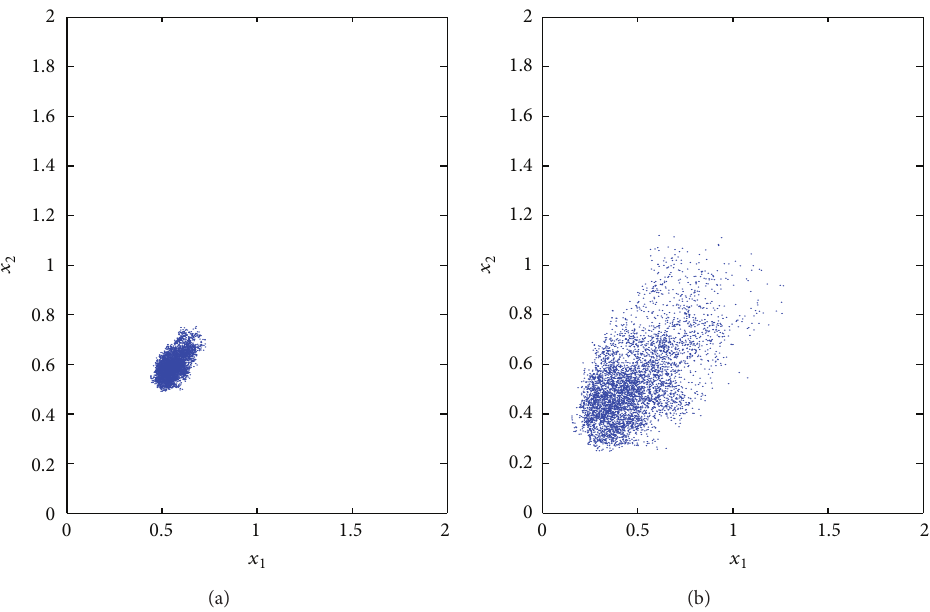
Figure 3: Population distribution of stochastic system (73) around the deterministic model’s positive equilibrium 𝑥 ∗ ≐ (0.5734, 0.6090) . = 0.1 , 𝜎 = 0.09 in left subgraph (a) and 𝜎 𝜎 1 2